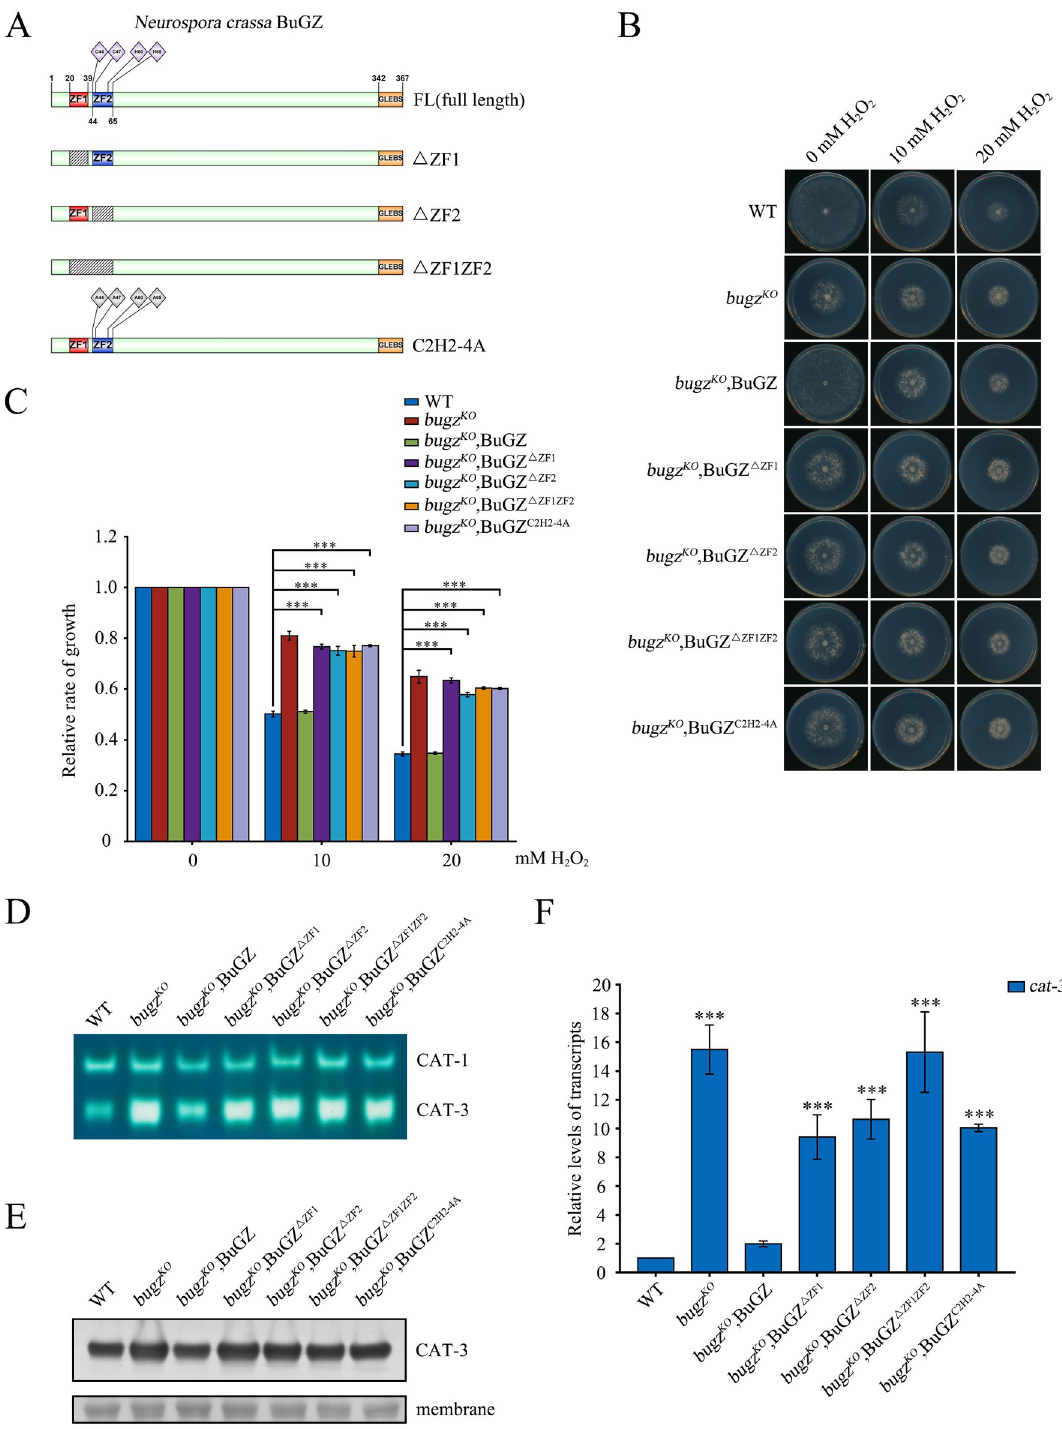
Fig 6. The intact zinc finger domains of BuGZ are essential for repressing cat-3 expression. (A) Schematic of full-length BuGZ and mutants with deletions or alanine substitutions (indicated by gray diamonds) in zinc finger domains. The position of zinc finger 1 (red rectangle), zinc finger 2 (blue rectangle), GLEBS domain (yellow rectangle) and zinc ion binding sites (light purple diamonds) are indicated. (B) Mycelial growth of WT, bugz KO , bugz KO ,BuGZ and transformants with various mutations in zinc finger domains on plates with 0, 10, or 20 mM H 2 O 2 . (C) Quantitation of growth rate of strains described in panel B relative to WT. (D) In-gel catalase activity assay of protein extracts from WT, bugz KO , bugz KO ,BuGZ and transformants with various mutations in zinc finger